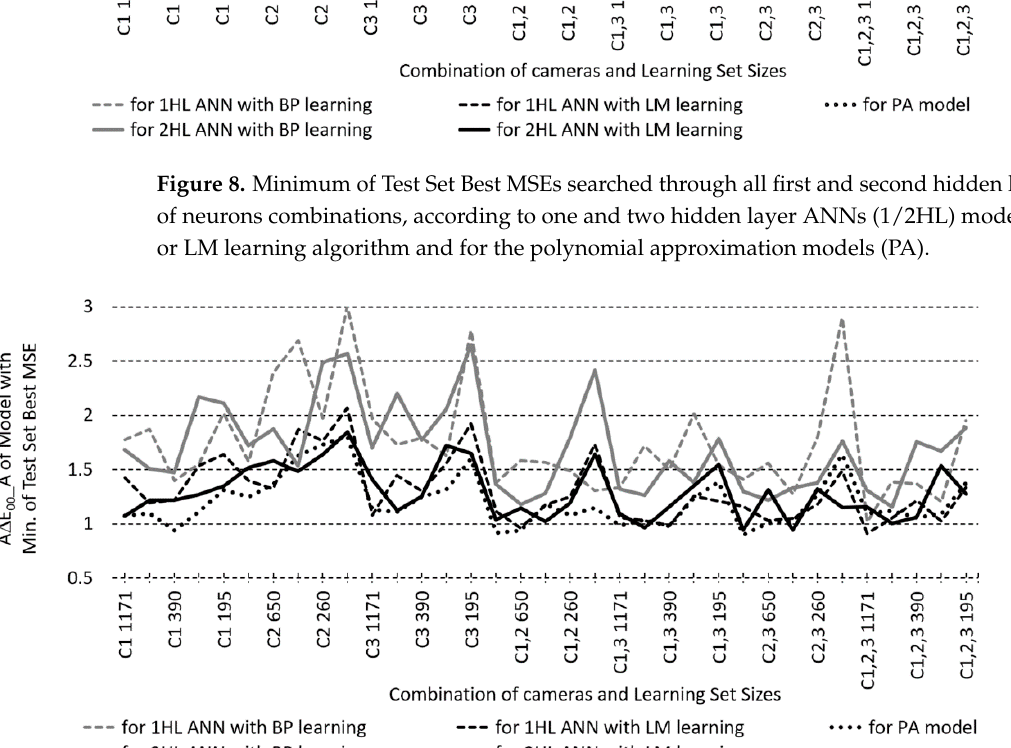
Figure 10. Comparison of the best test set average CIEDE2000 colour differences with illuminant A (A ∆ E* 00 _A) for ANN and PA models, according to one and two hidden layer ANNs (1/2HL) mod- elled with BP or LM learning algorithm and for the polynomial approximation models (PA).